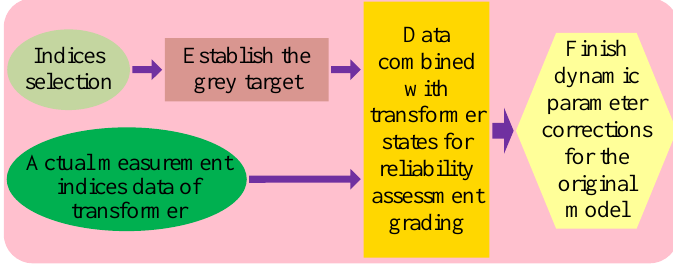
Figure 3. The flow chart of dynamic correction.